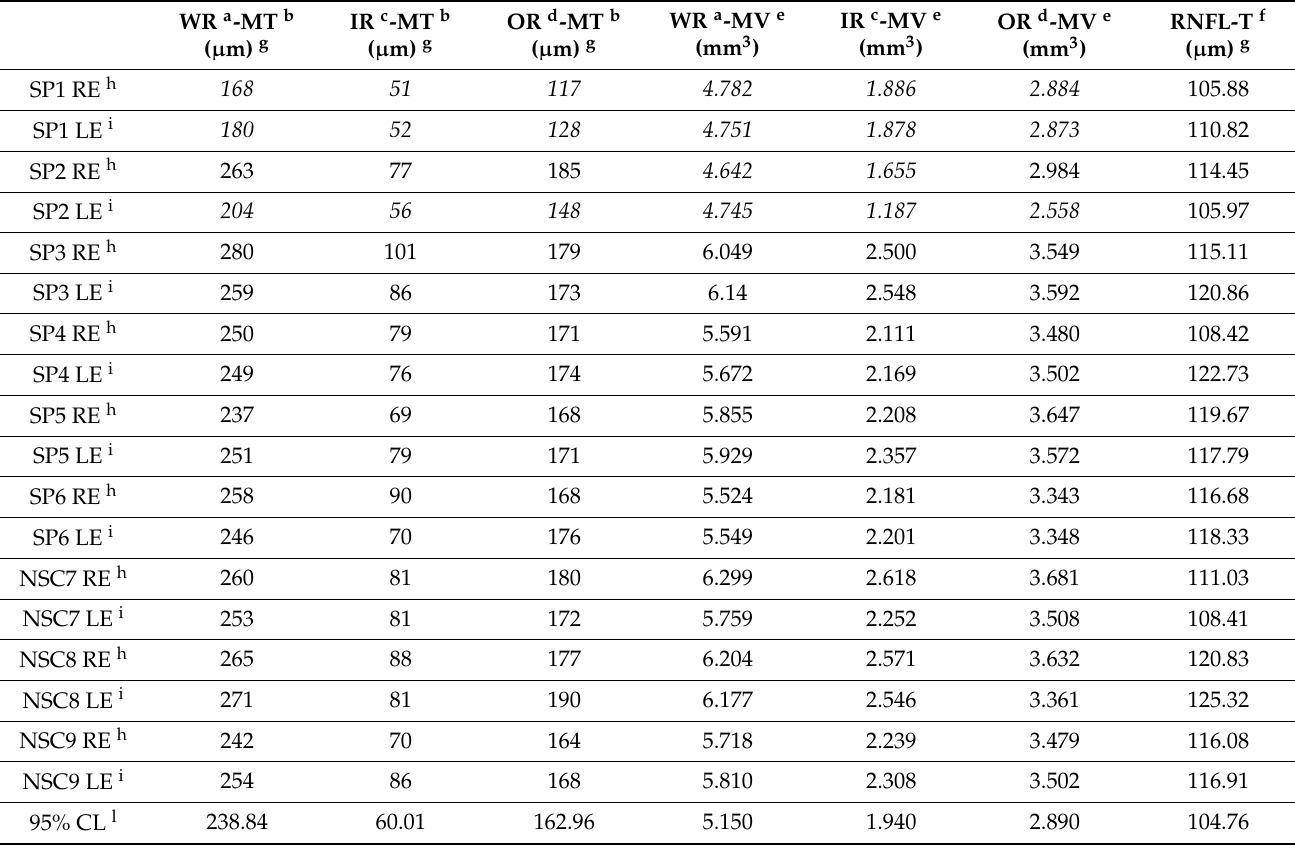
Table 3. Spectral domain-Optical Coherence Tomography data in spinocerebellar ataxia type 1 subjects with (SP) and without (NSC) neurological